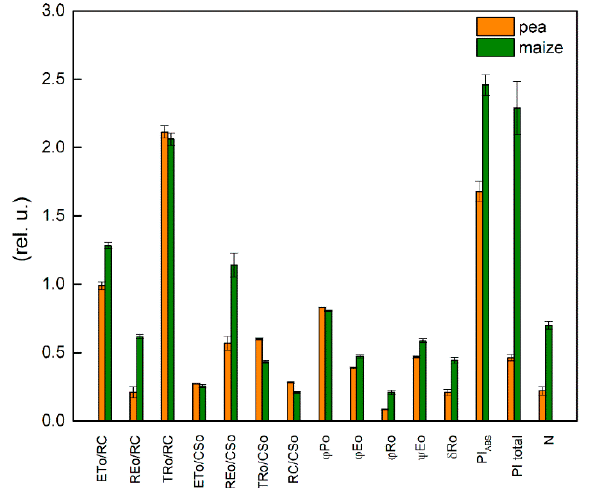
Figure 7. Selected JIP parameters (Table 1) were measured in leaves of pea and maize under physiological conditions. Mean values (± SE) were calculated from 20 independent measurements.